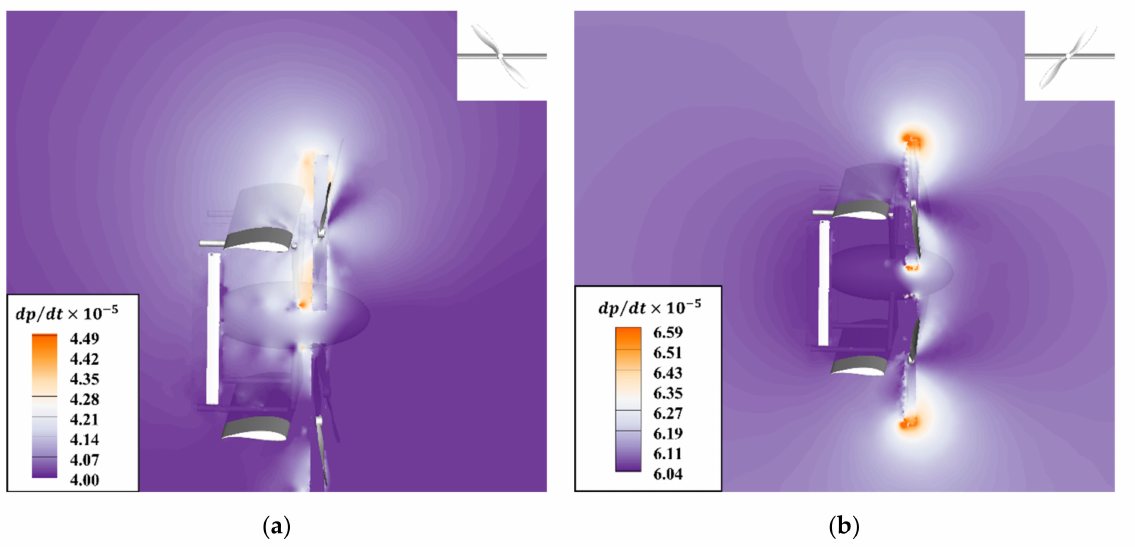
Figure 14. Snapshot of dilatation field on a slice passing through the propeller hub: ( a ) γ = 45; ( b ) γ = 135 ◦ .